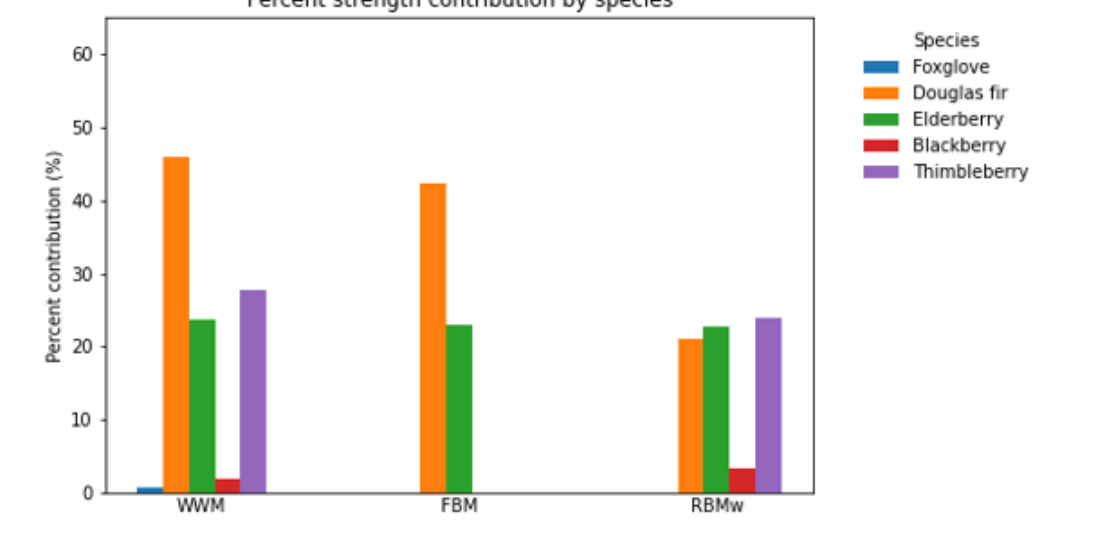
Figure 13. Contribution of root cohesion by species calculated for each of the three models. Because of the nonlinearity of the FBM and RBMw models, the contributions for FBM and RBMw will not necessarily sum to 100%.